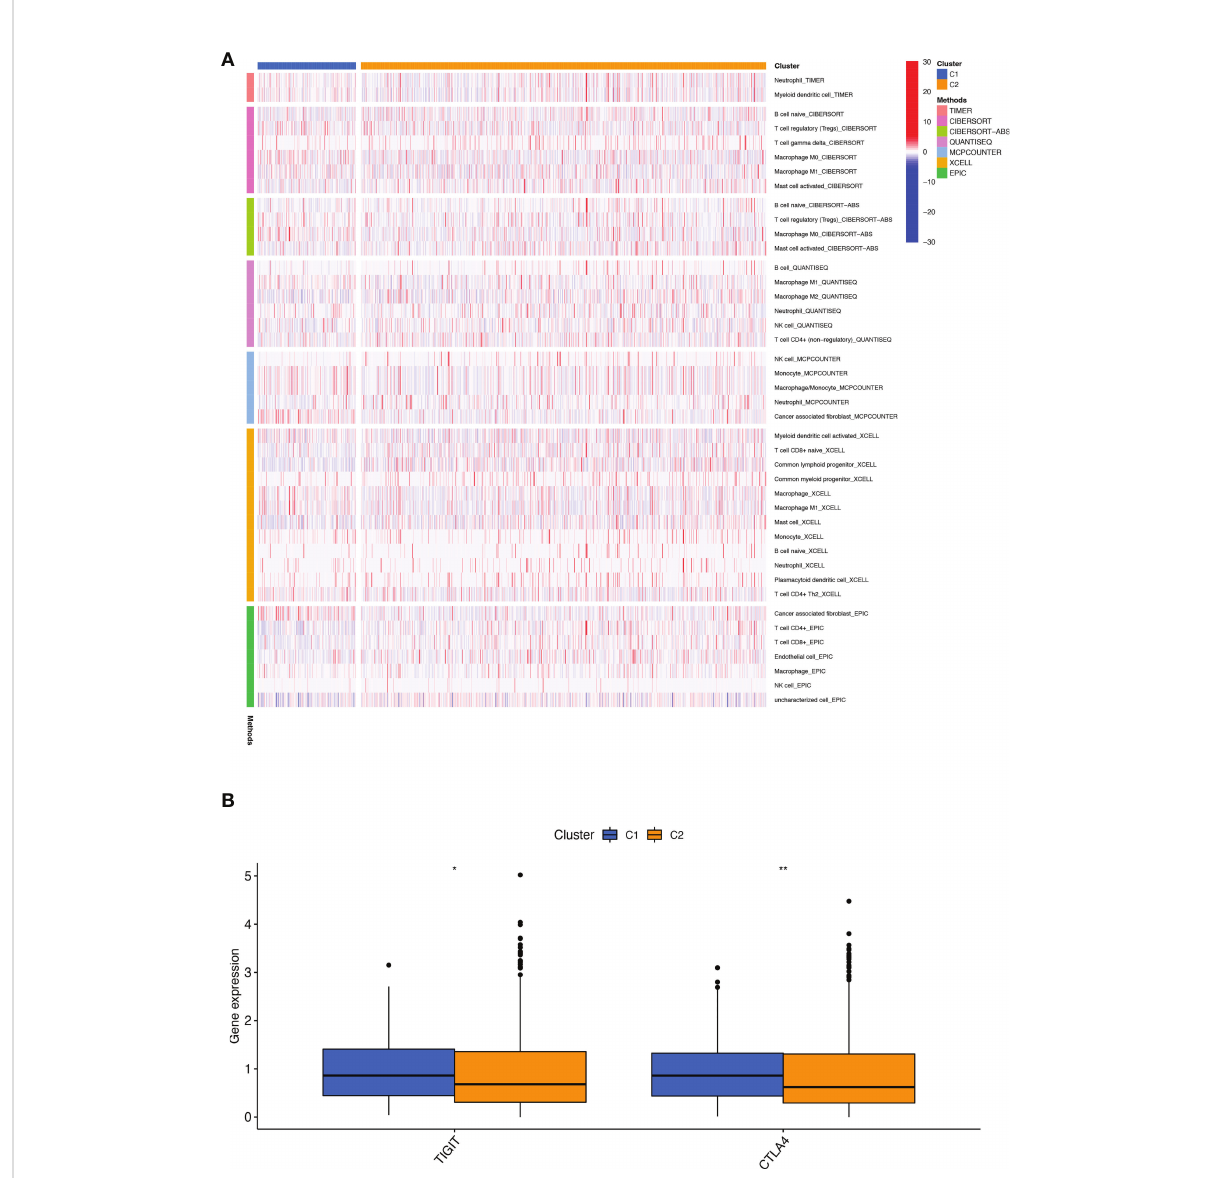
FIGURE 8 In fi ltration and expression of immune cells, immune checkpoints in different clusters. (A) Analysis of in fi ltrating cells in two different clusters by using multiple algorithms. (B) Differential expression analysis of 2 immune checkpoint genes in different clusters. *p < 0.05; **p <